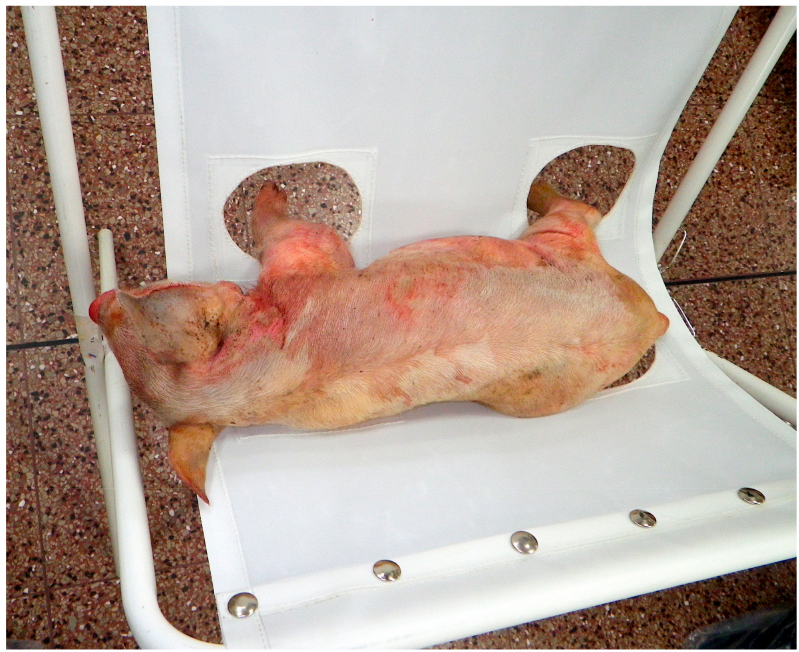
Figure 4. Sailcloth hammock in use (cadaver used to demonstrate restraint).